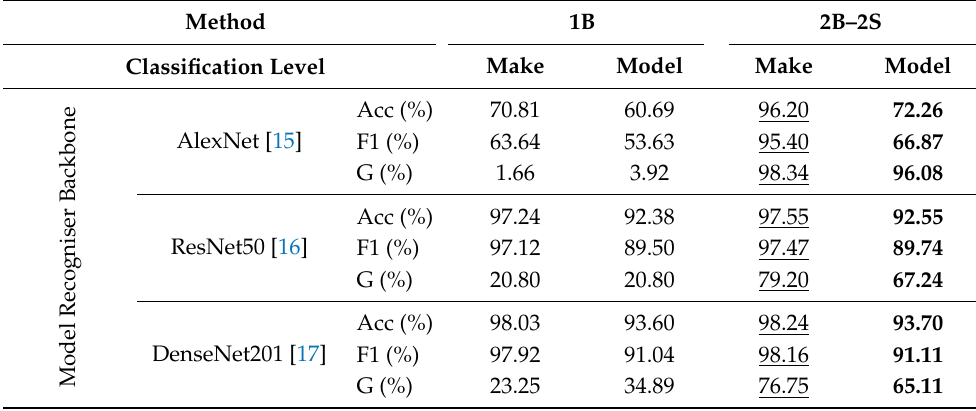
Table 9. VMMR results on VMMRDB-495